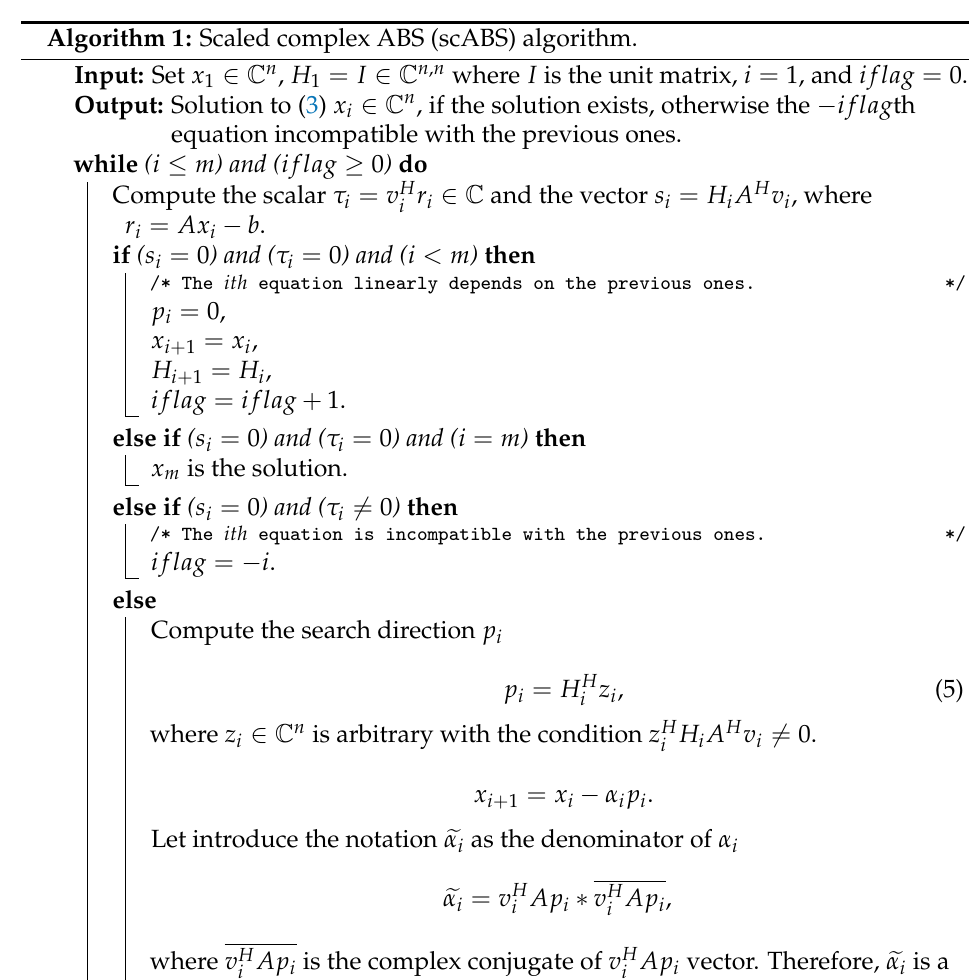
Algorithm 1: Scaled complex ABS (scABS)